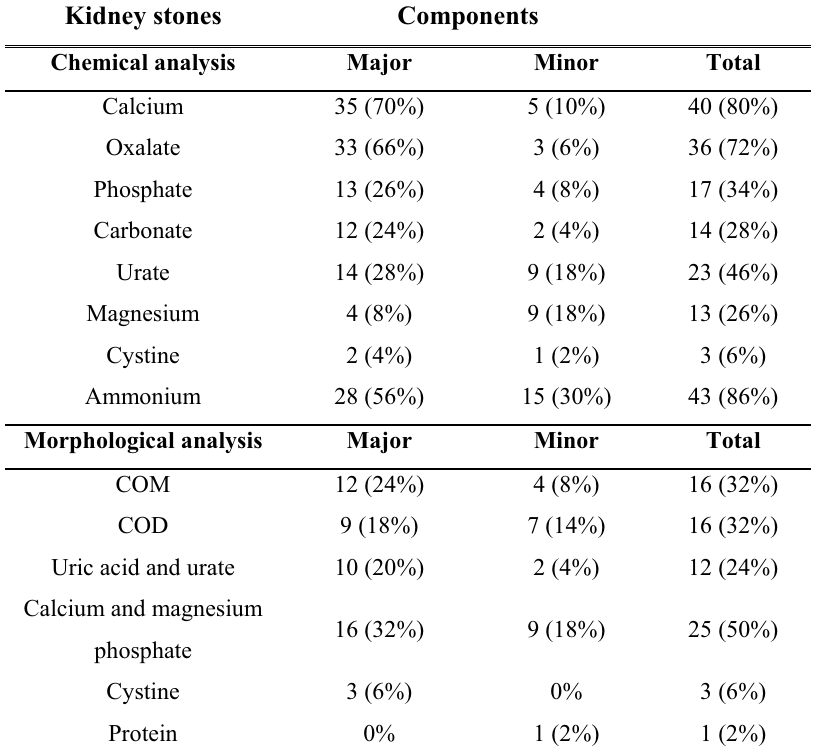
TABLE 1 - Comparison of chemical and morphological findings of 50 kidney stones